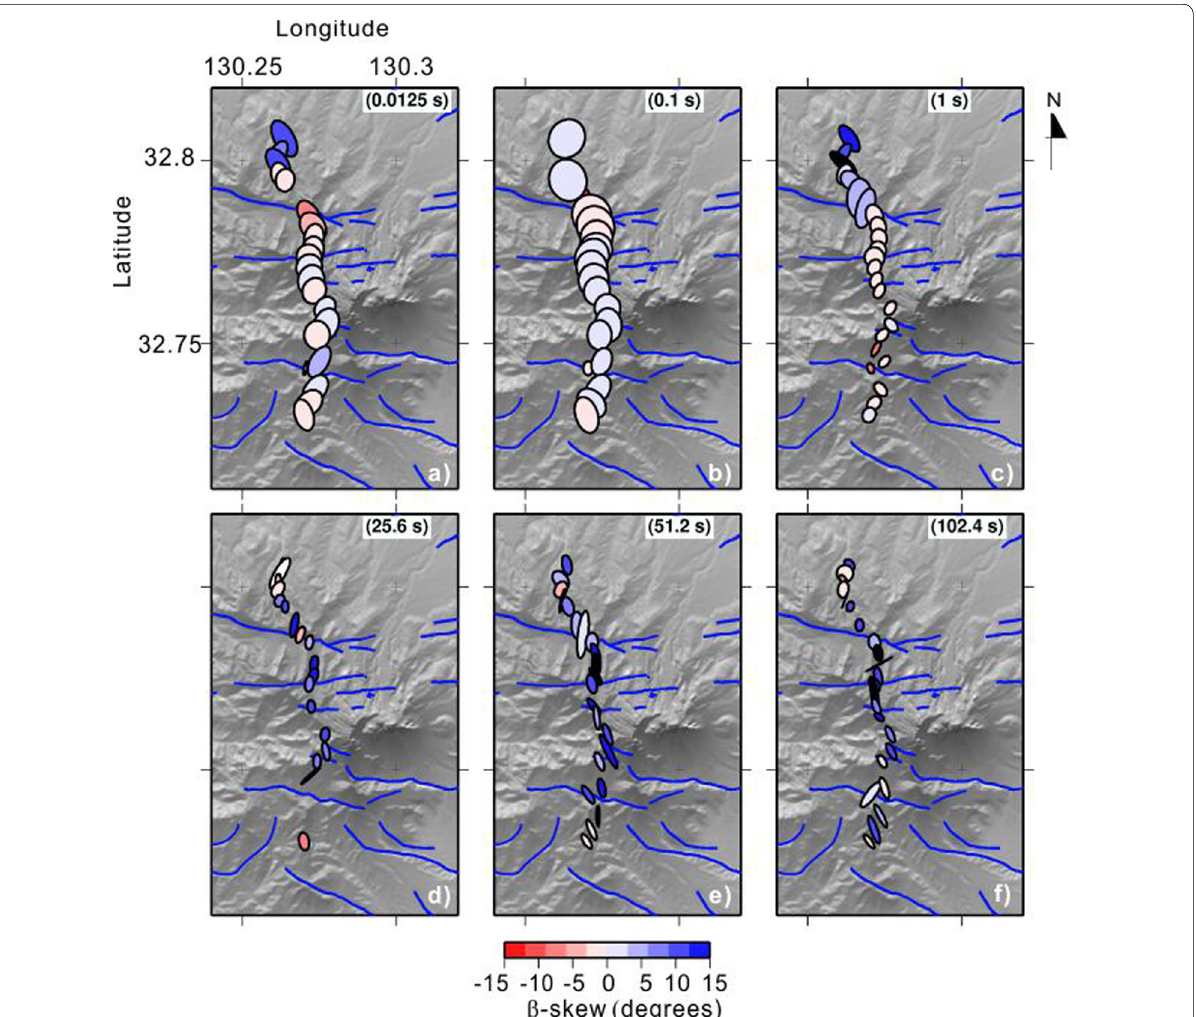
Fig. 2 Phase tensor ellipse (Caldwell et al. 2004) maps for different sounding periods (0.00125 s, 0.1 s, 1 s, 25.6 s, 51.2 s, 102.4 s). Color-filled ellipses represent the phase tensor ellipse with its orientation derived from azimuth α − β . The color indicates β skew angle. The sites having very large error bars (outliers) at the corresponding periods are removed. Site dependent of orientation strongly indicate 3-D